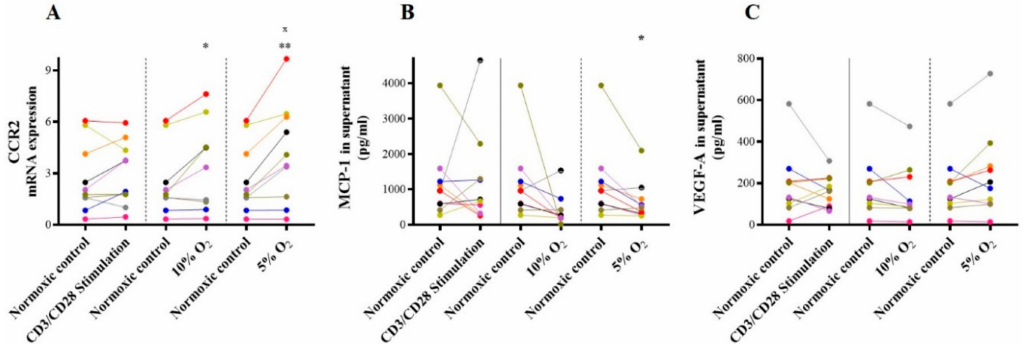
Figure 4. CCR-2, MCP-1, and VEGF-A in vitro. In vitro mRNA expression of ( A ) CCR-2 and ( B )